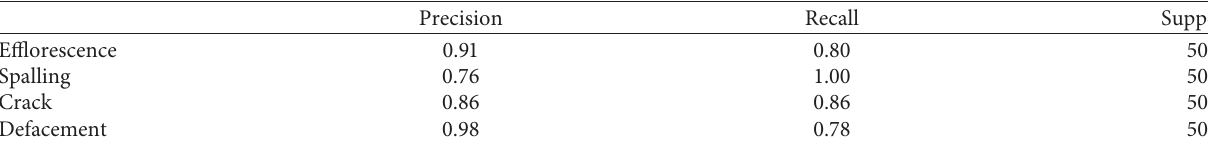
Table 1: Classification report.